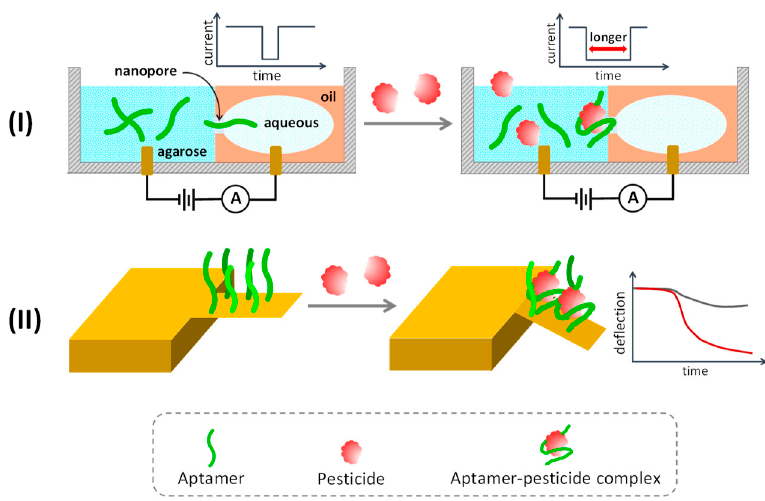
Figure 7. Ionic current-based aptasensors ( I ) (adapted with permission from Reference [147], copyright 2017 Royal Society of Chemistry) and microcantilever-based aptasensors ( II ) (adapted with permission from Reference [148] copyright 2018 Elsevier) for pesticide detection.